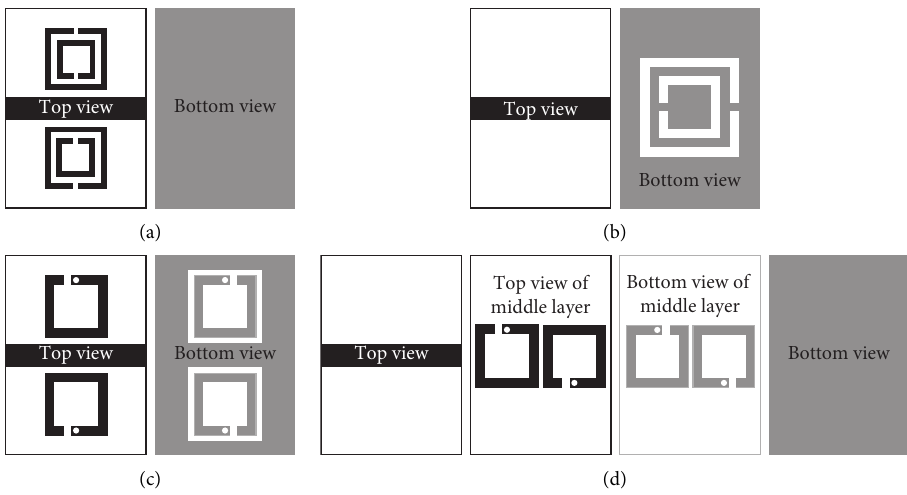
Figure 1: Different subwavelength planar resonators employed in the design of miniaturized planar microwave circuits: (a) SRRs, (b) CSRRs, (c) BC-SRs which are magnetically coupled to a line, and (d) BC-SRs which are electrically coupled to a